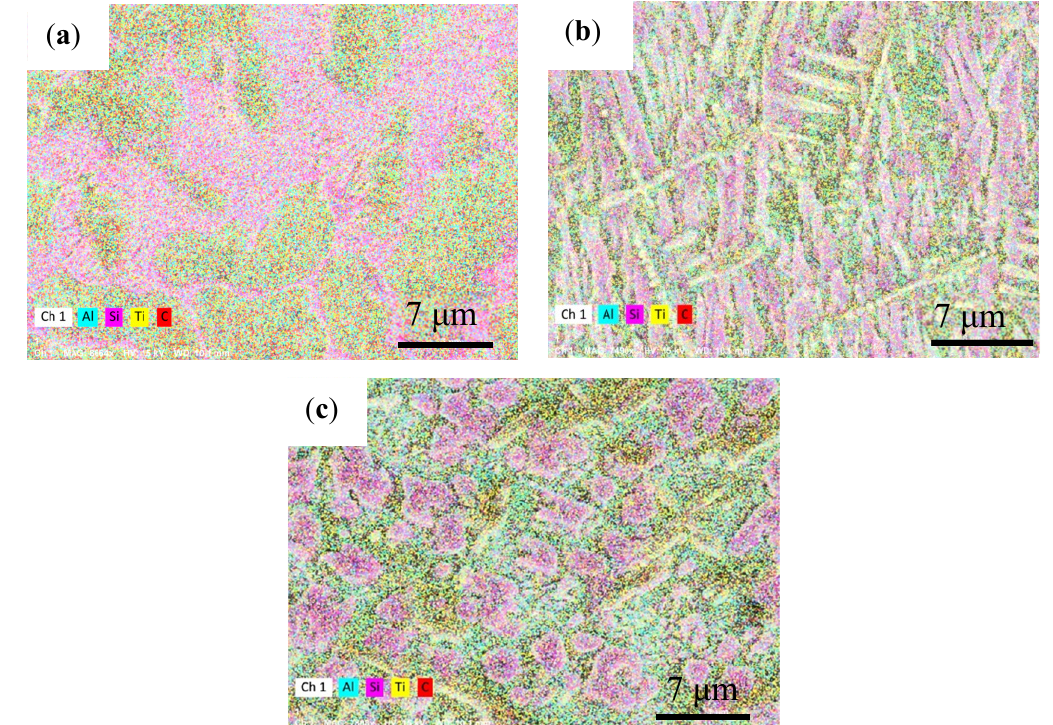
Figure 7. EDS mapping of Ti-Al-Si-6TiC composite showing distribution of elements at the ( a ) interface, ( b ) middle and ( c ) upper zones.